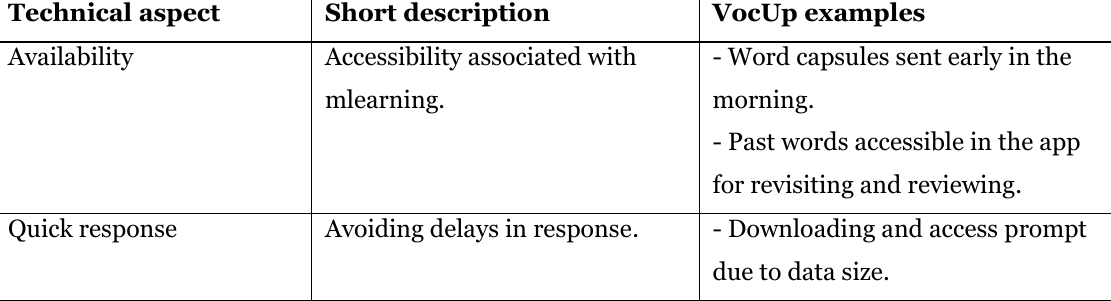
Towards A Quality Model of Technical Aspects for Mobile Learning Services With Added VocUp